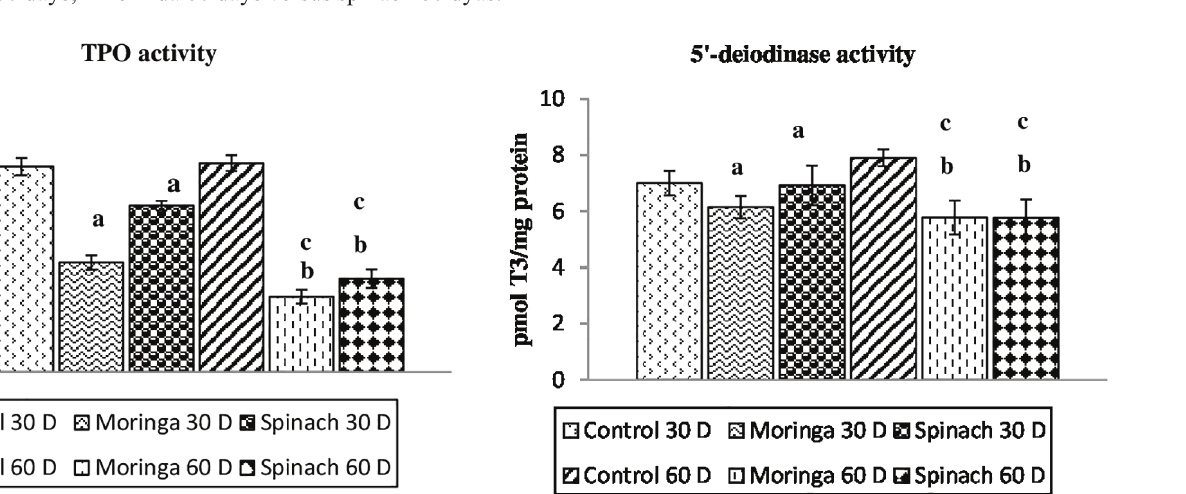
FIGURE 2 - Unirany excretion of iodine and thiocyanate of selected plant foods treated animals for 30 days and 60 days. Each bar denotes mean±SD, n=8. Mean values are significantly different at p<0.05. a Control 30 days versus moringa 30 days; b Control 30 days versus spinach 30 days; c Moringa 30 days versus spinach 30 days; a’ Control 60 days versus moringa 60 days, b’ Control 60 days versus spinach 60 days; c’ Moringa 60 days versuas spinach 60 days; x Control 30 days versus moringa 30 days; y Control 30 days versus spinach 30 days; z Moringa 30 days versus spinach 30 days, x’ Control 60 dyas versus moringa 60 days; y’ Control 60 days versus spinach 60 days; z’ Morinda 60 days versus spinach 60 dyas.